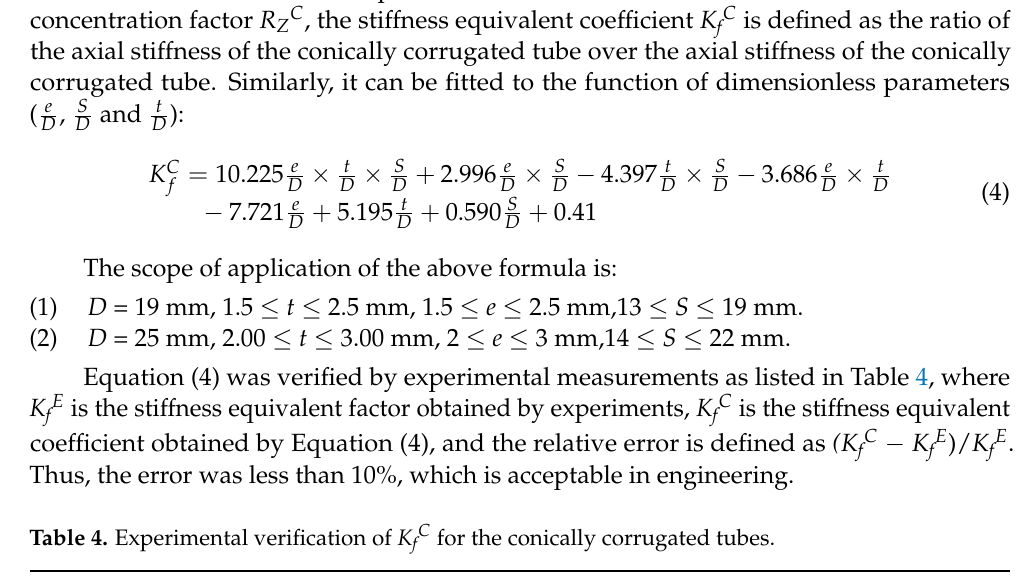
The scope of application of the above formula is: